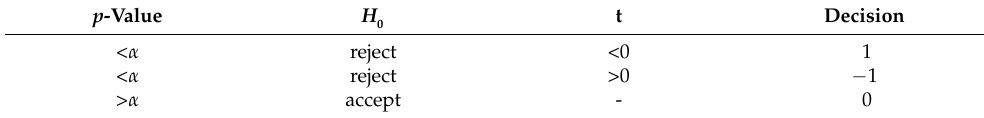
Table 6. How the null hypothesis is rejected (or accepted) and the decision is